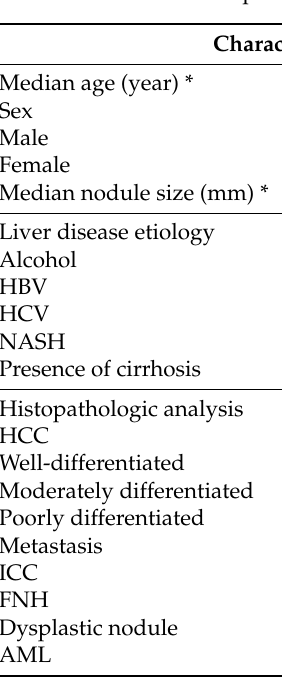
Figure 2. Flow diagram of study. Table 1. Clinical and histopathologic data ( n = 102).